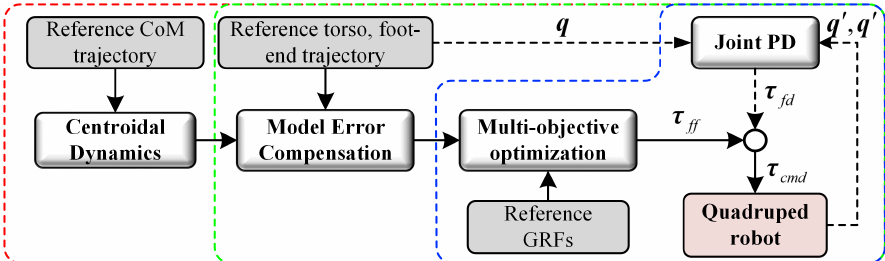
Figure 6. Block diagram of the three different controllers exerted on simulations and a real hydraulic quadruped platform. Blue dotted area indicates a pure joint PD controller with refined parameters tuning. Red dotted area indicates the proposed optimal torque control scheme composed of joint low-gain PD + MEC+ centroidal dynamics-based CoM trajectory tracking (CD). Joint low-gain PD + MEC controller is encapsulated by green dotted area.